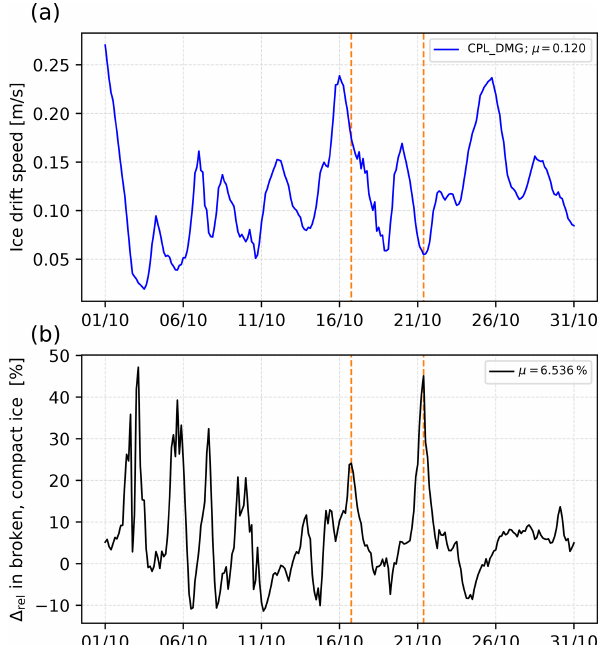
Figure 15. Temporal evolution of (a) the ice drift velocity aver- aged over all of the ice-covered parts of the domain (see Fig. 8 for the domain definition) for the CPL_DMG simulation through- out October 2015 and (b ) the difference of ice drift velocity in the region covered by compact sea ice that has been recently broken (defined as D max ≤ 200m and c ≥ 0 . 8) between the CPL_WRS and CPL_DMG simulations. The sea ice-covered part of the do- main corresponds to the area for which the sea ice concentration c is greater than 0. The two orange vertical lines indicates the dates of the snapshots shown in Figs. 10, 11 and 13. In each panel legend, µ indicates the temporal mean of the plotted